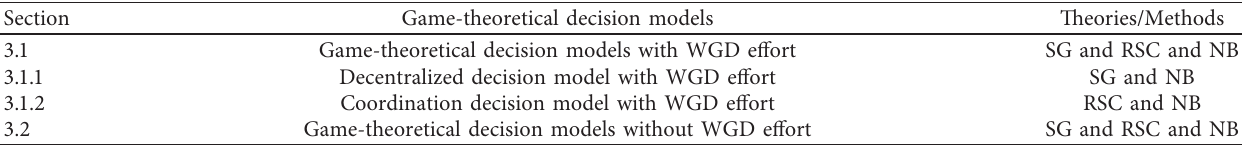
Table 2: Framework of game-theoretical decision